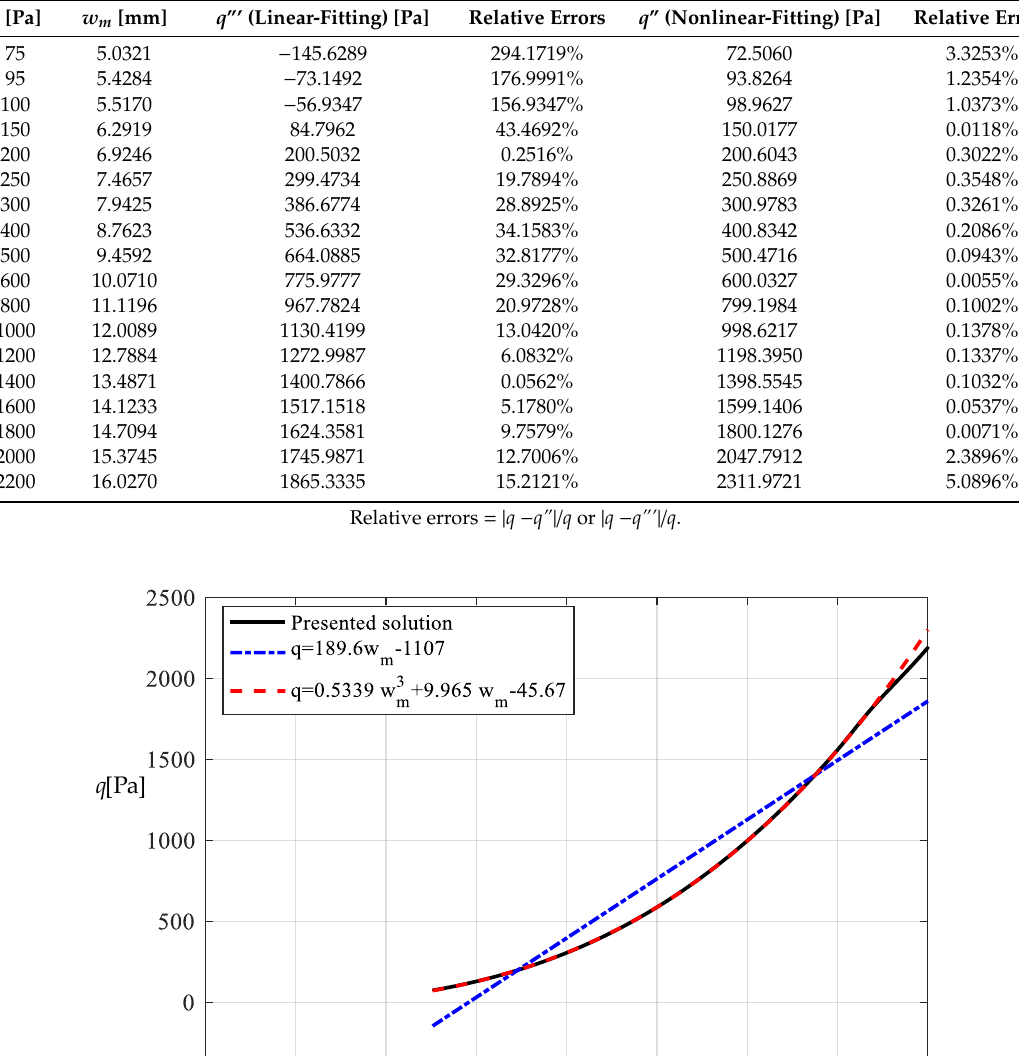
Table 3. The fitting results to the data in Table 2 with least square method.